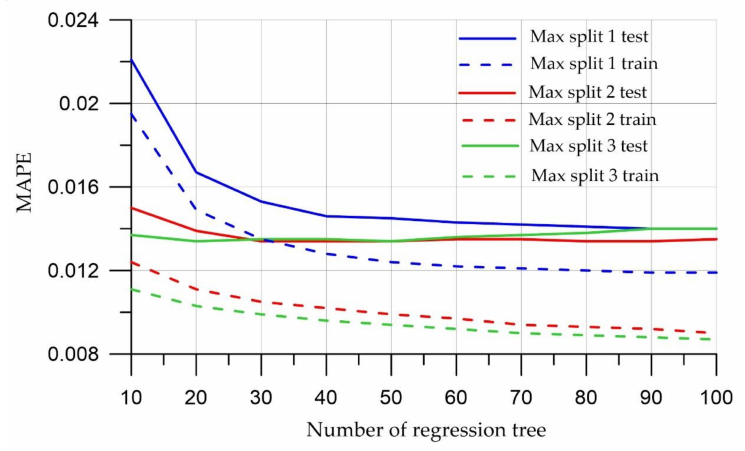
Figure 5. Mean Absolute Percentage